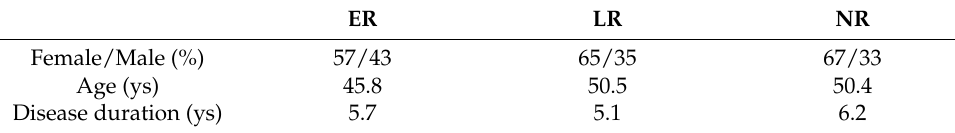
Table 1. Selected baseline variables from 132 South Italian CSU